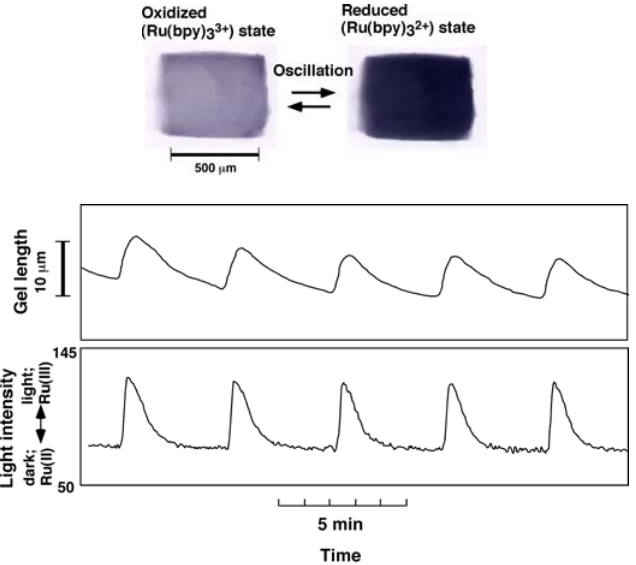
Figure 2. Periodic redox changes of the miniature cubic poly(NIPAAm-co-Ru(bpy) 32+ ) gel (lower) and the swelling-deswelling oscillation (upper) at 20 °C. Color changes of the gel accompanied by redox oscillations (orange: reduced state, light green: the oxidized state) were converted to 8-bit grayscale changes (dark: reduced, light: oxidized) by image processing. Transmitted light intensity is expressed as an 8-bit grayscale value. Outer ] = 84mM; [HNO ] = 0.6M (Reference solution: [MA] = 62.5mM; [NaBrO 3 3